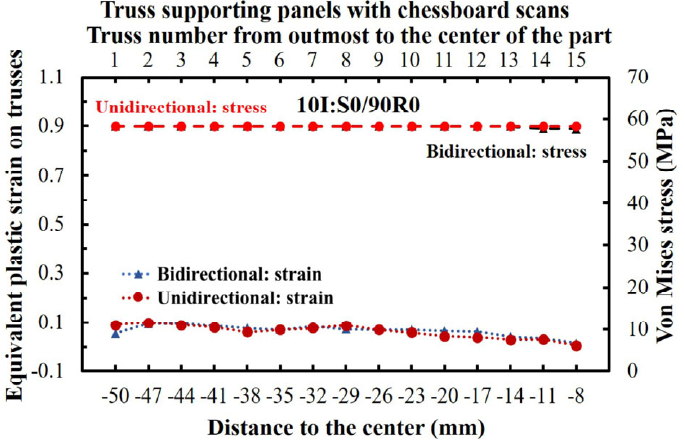
Figure 20. The equivalent plastic strain and von Mises stresses on each truss of chessboard scanned parts.